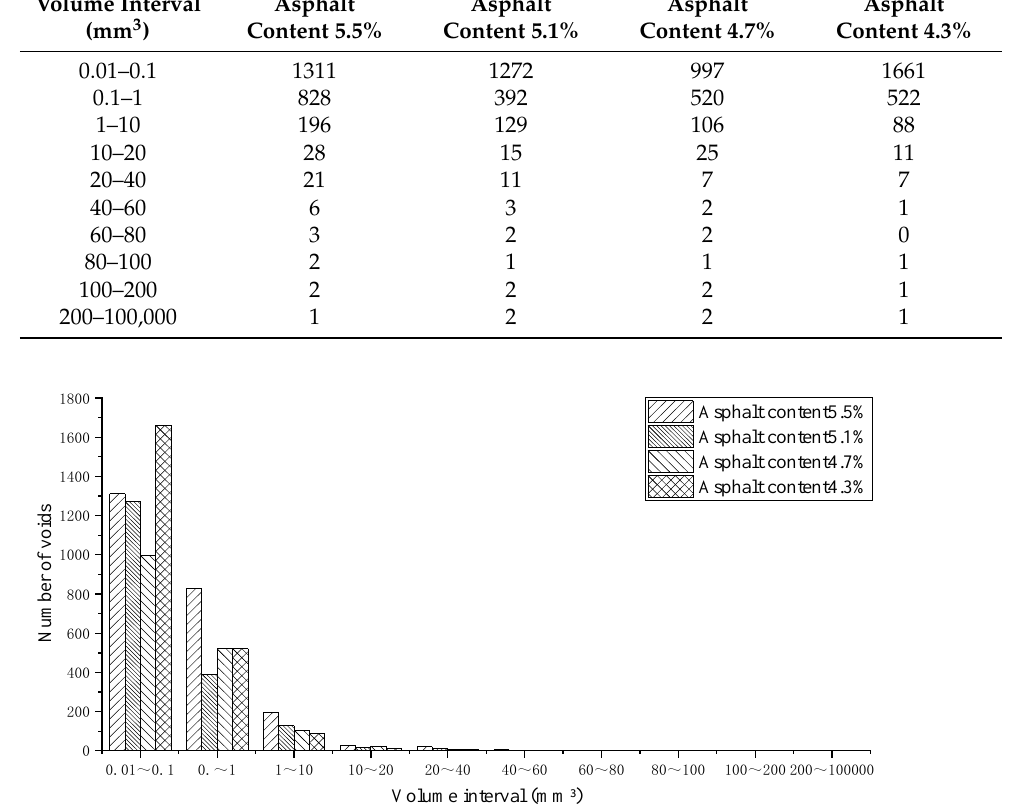
Figure 8. Bulk void quantity distribution of EPA-13 under different asphalt contents. According to the test results, the number of voids in the porous asphalt mixture specimen is very high, and the closed voids below 1 mm 3 account for more than 89% of all voids.